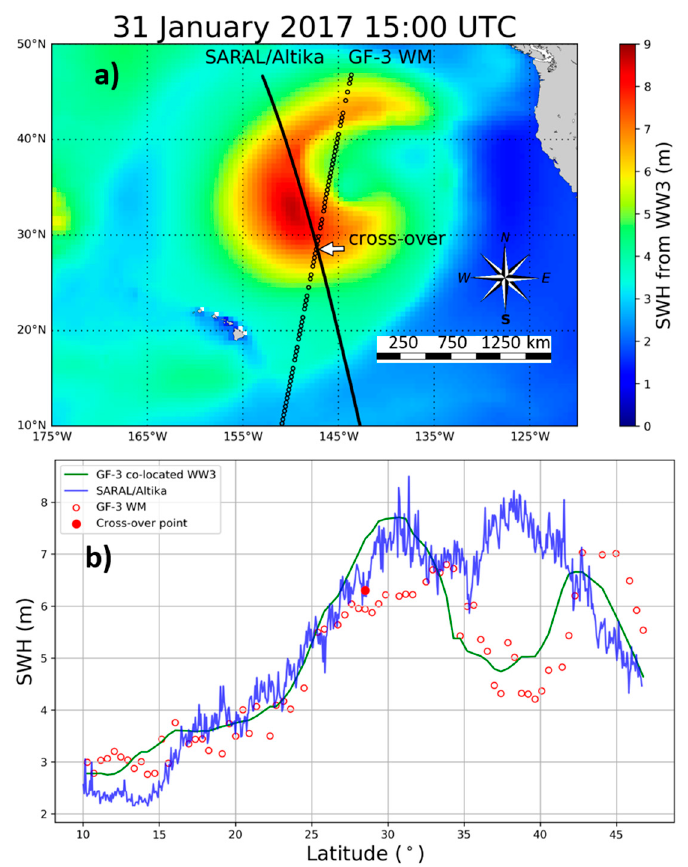
Figure 11. GF-3 WM, SARAL/Altika, and WW3 SWH comparisons for the case on 31 January 2017. ( a ) Colors represent the WW3 SWH hindcast at 15:00 UTC, with lines and circles denoting the tracks of GF-3 and SARAL/Altika, respectively; ( b ) Red circles and the green line represent the SWH from QPCWAVE_GF3 retrievals and WW3 along the transect of GF-3, and blue line is the SARAL/Altika-derived SWH.